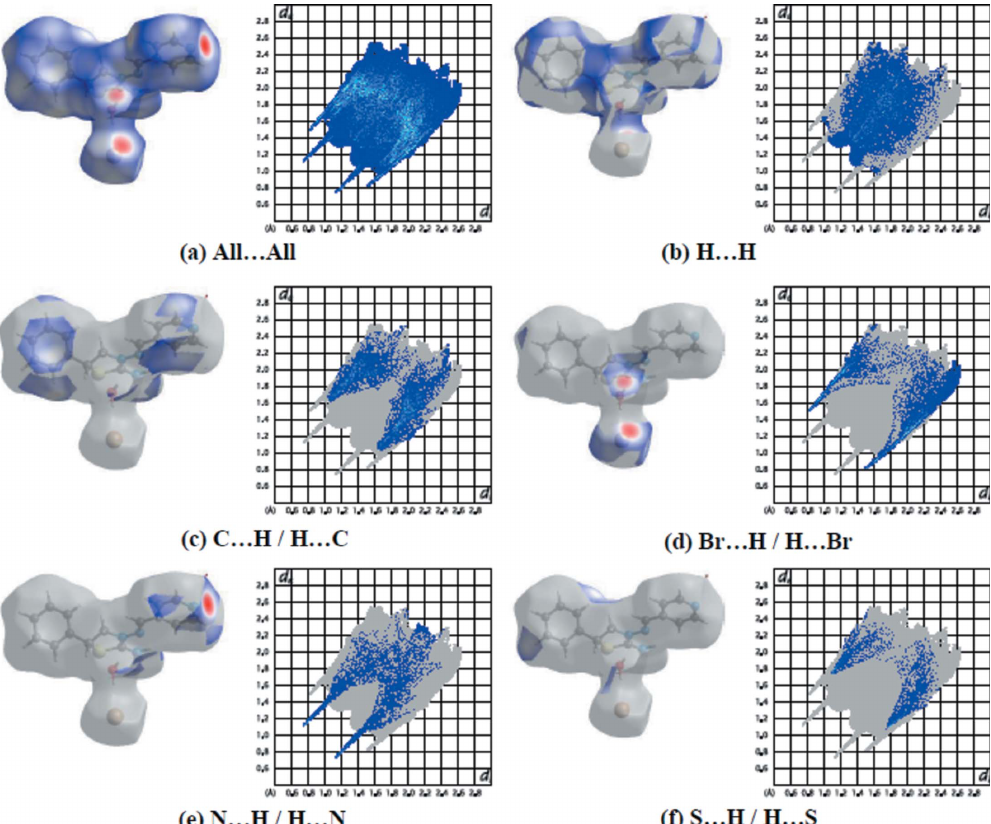
Figure 5 The two-dimensional fingerprint plots of the title compound, showing ( a ) all interactions, and delineated into ( b ) H (cid:2)(cid:2)(cid:2) H, ( c ) C (cid:2)(cid:2)(cid:2) H/H (cid:2)(cid:2)(cid:2) C, ( d ) Br (cid:2)(cid:2)(cid:2) H/ H (cid:2)(cid:2)(cid:2) Br, ( e ) N (cid:2)(cid:2)(cid:2) H/H (cid:2)(cid:2)(cid:2) N and ( f ) S (cid:2)(cid:2)(cid:2) H/H (cid:2)(cid:2)(cid:2) S interactions [ d e and d i represent the distances from a point on the Hirshfeld surface to the nearest atoms outside (external) and inside (internal) the surface,